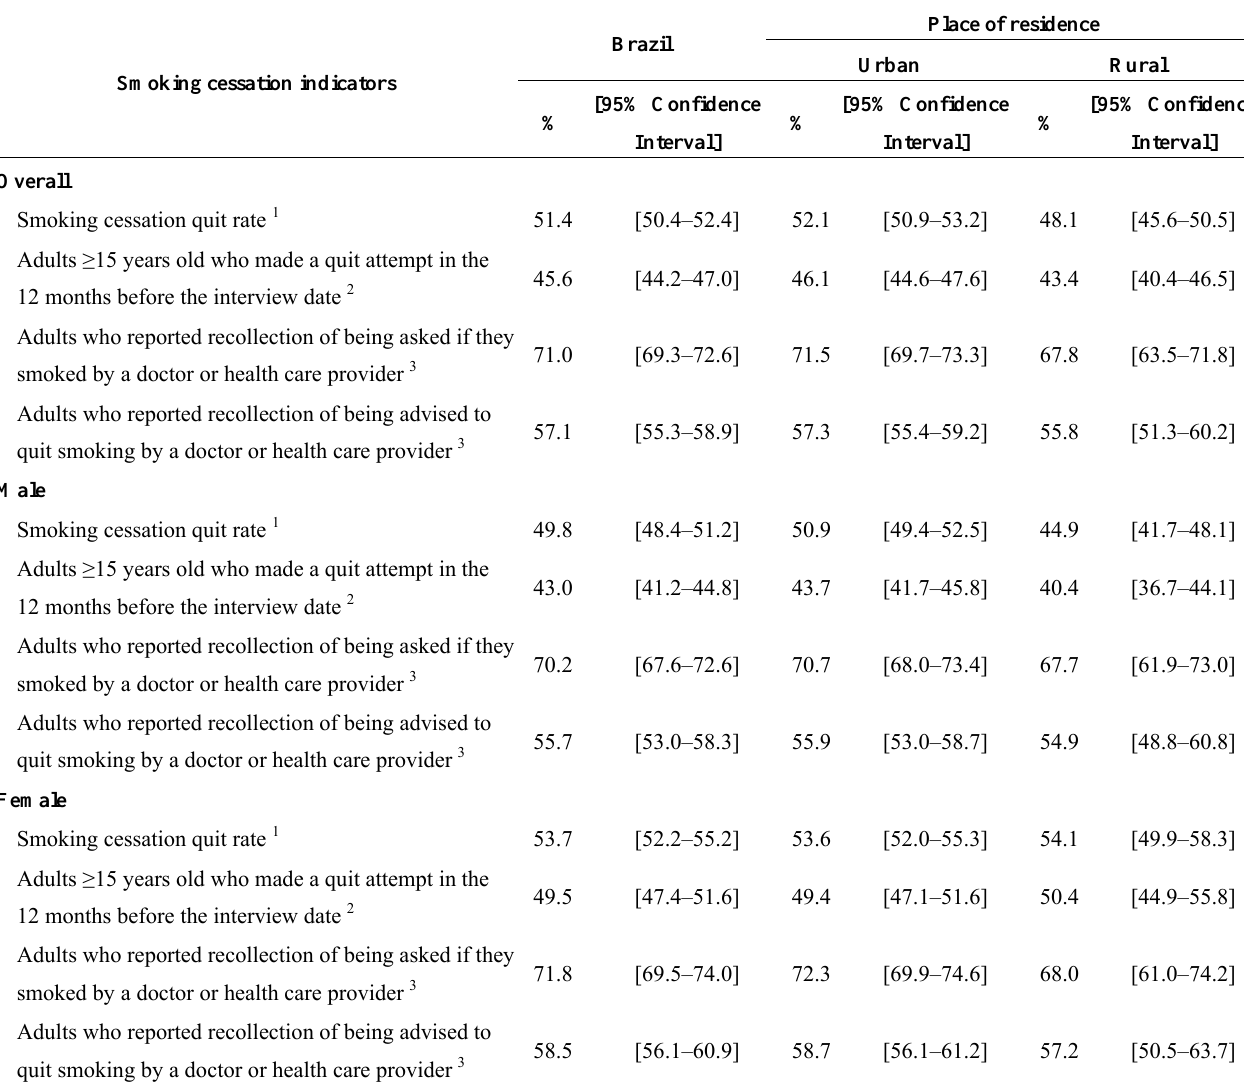
Table 4. Smoking cessation indicators for adults ≥ 15 years old, by place of residence and gender, GATS Brazil,